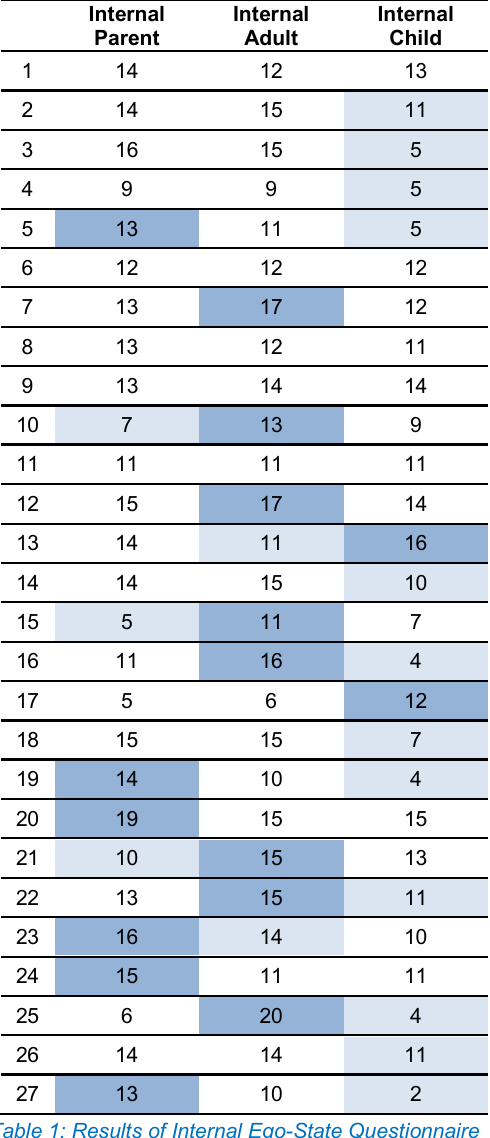
Table 1: Results of Internal Ego-State Questionnaire (Hay